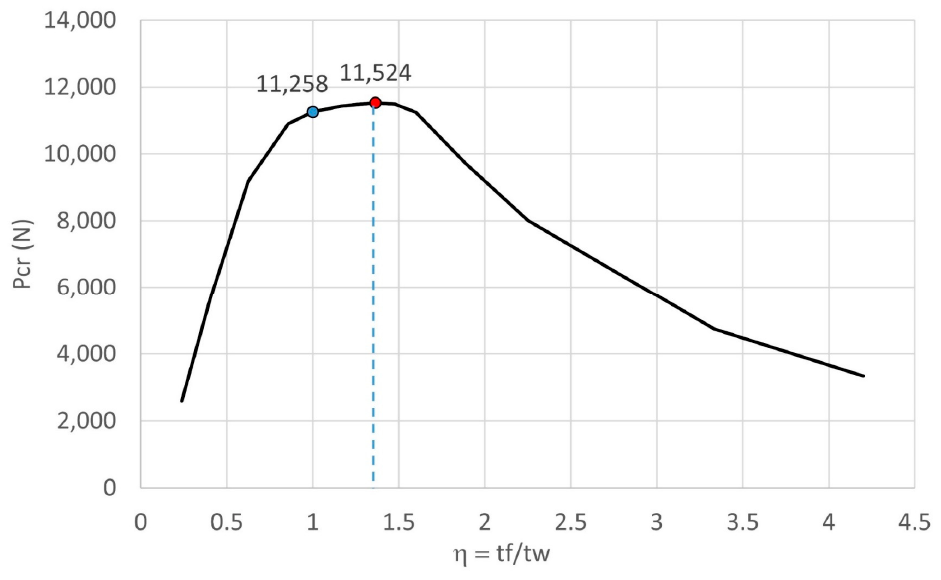
Figure 12. Relation effect of web and flange thickness on critical buckling load.